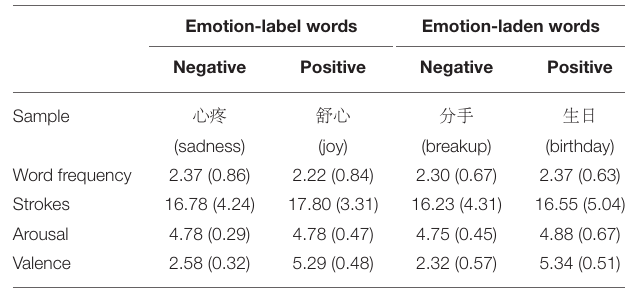
TABLE 2 | Mean and SD in brackets for word characteristics for Chinese emotion-label words and emotion-laden words as targets. Emotion-label words Emotion-laden